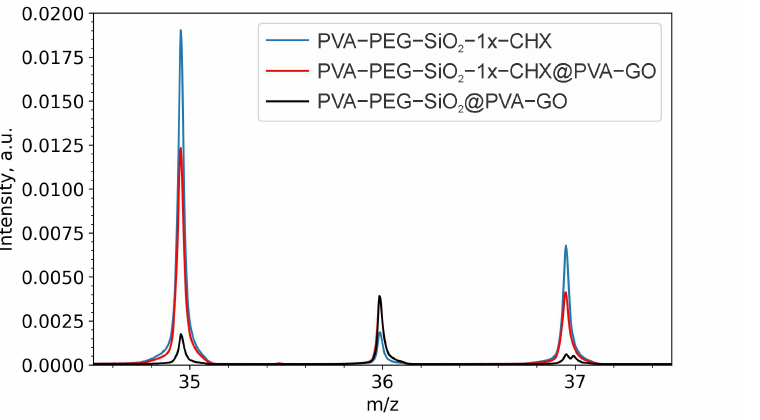
Figure 7. ToF-SIMS spectra obtained in the negative ion mode of core PVA-PEG-SiO 2 -1x-CHX, core–shell PVA-PEG-SiO 2 -1x-CHX@PVA-GO and core–shell PVA-PEG-SiO 2 @PVA-GO.